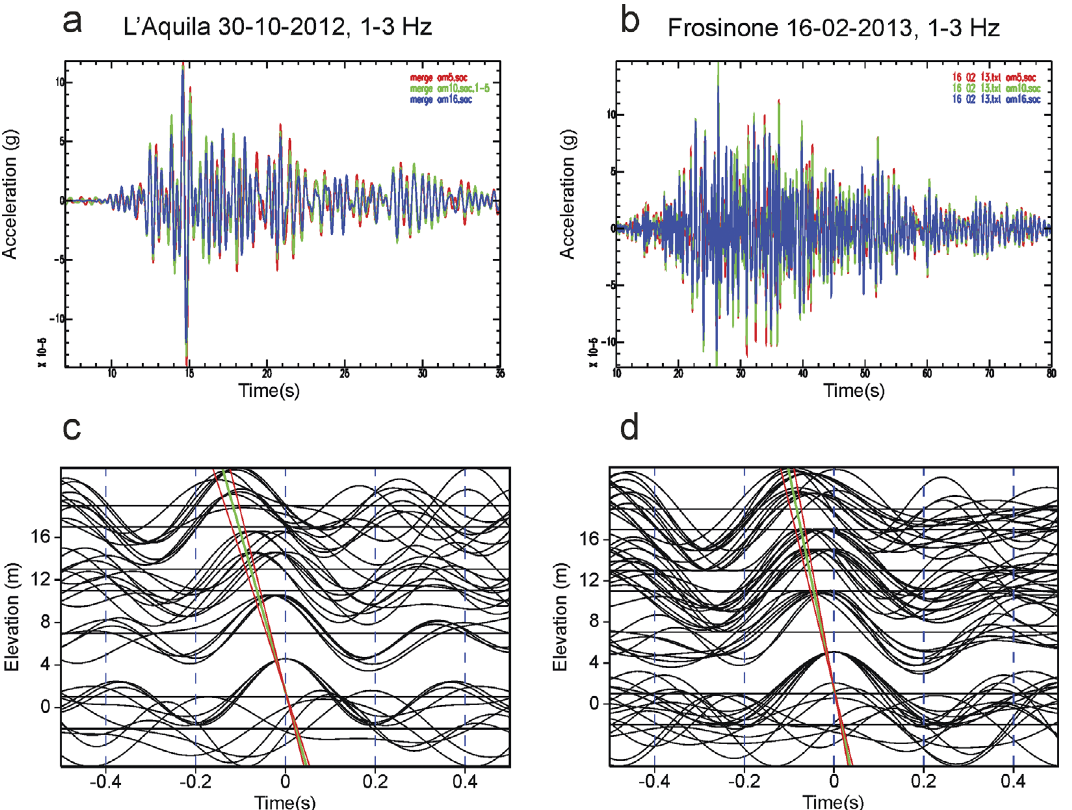
Figure 11. Comparison of the signals acquired by three accelerometers (x components; AM5, AM10 and AM16) installed at 1.5 m height for the M 3.6 (a) and the M 4.8 (b) event. The signals are filtered in the 1-3 Hz frequency band. The results of interferometric analysis performed using the sensor AM16 as reference for both events are shown in (c) and (d). The cross-correlation signals are normalized for the maximum trace value and are organized according to the height of accelerometers. The slope of the green line (in absolute value) is equal to the shear wave velocity estimated by the picks of the maximum of positive pulses. The thin red lines represent the estimated uncertainties of